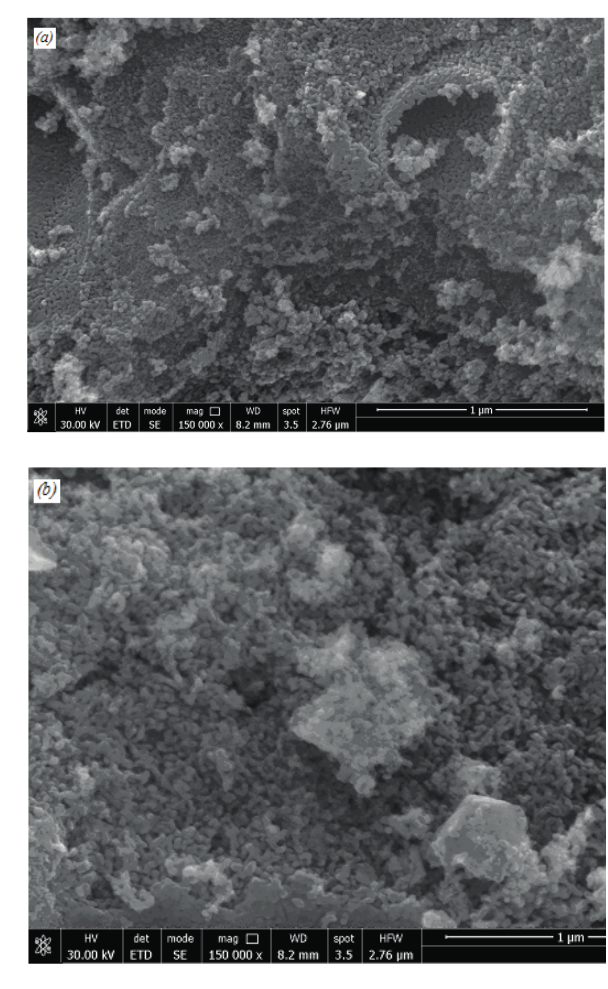
O (M II = Mg, Cu) ferrites: (a) MgFe 2 4